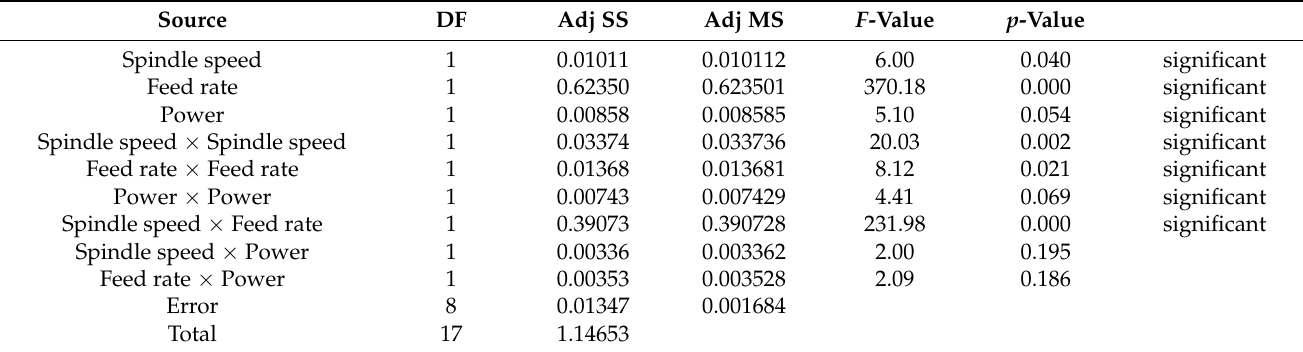
Table 8. ANOVA results for the surface roughness with water-soluble sago starch cutting fluid.